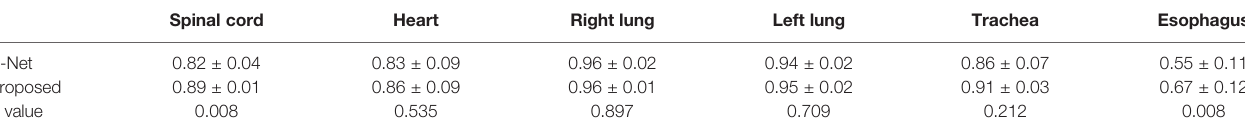
TABLE 2 | Comparison of DSC of two models ( (cid:2) x ± s ). Spinal cord Heart Right lung Left